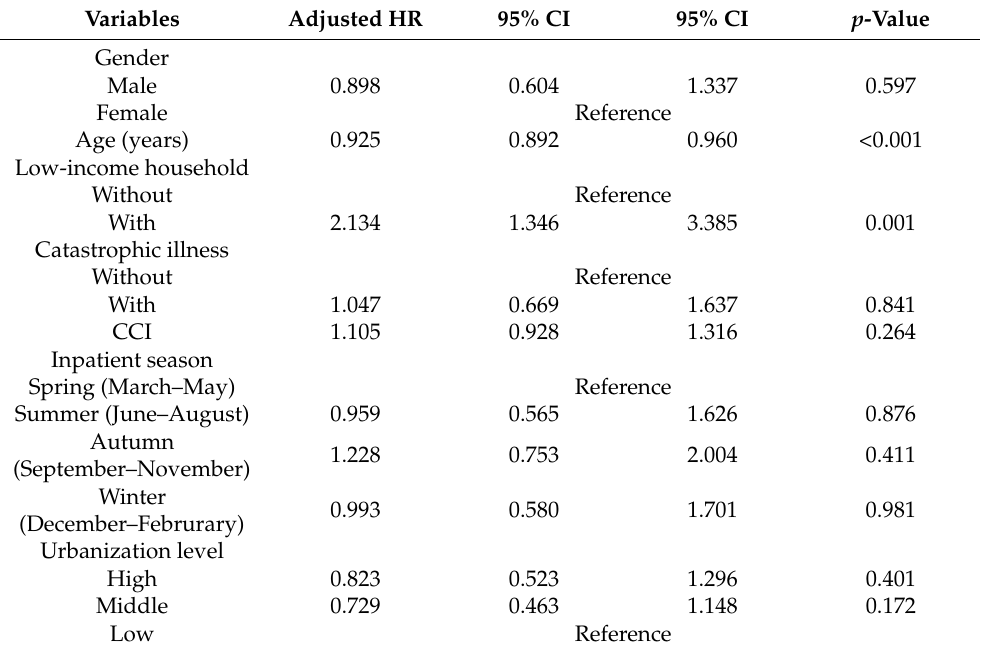
Table 7. Factors of injured hospitalized ADHD children at the end of follow-up using Cox regression. Variables